Question: Write a single sentence explaining what this figure depicts.
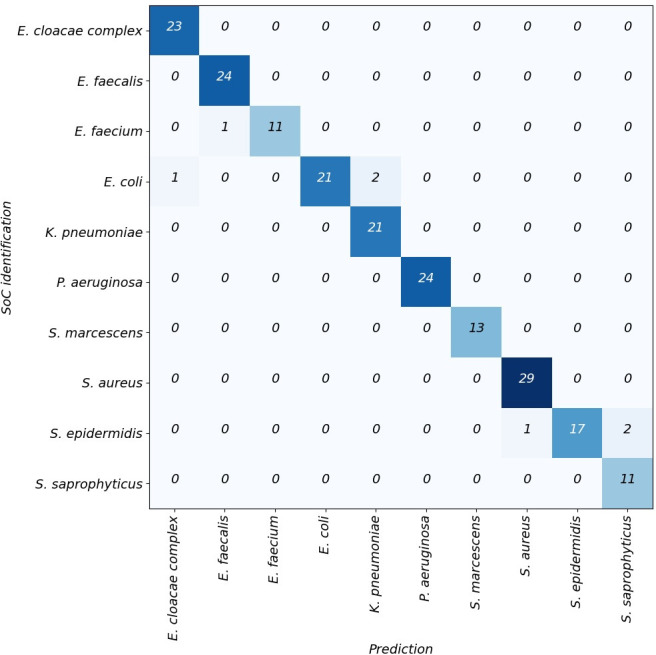
Answer: Confusion matrix of bacterial species identification using the BAIO-DX system and the phylogenetic thresholds. Confusion matrix comparing species-level predictions made by the BAIO-DX system to the reference identifications obtained by MALDI-TOF mass spectrometry for the 201 clinical isolates tested, belonging to the species included in the training data set and passing the species-level confidence threshold. Correct predictions appear along the diagonal, while off-diagonal values indicate misidentifications. The matrix illustrates the overall accuracy and the distribution of classification errors, demonstrating high concordance between the automated holography-based approach and SoC methods.